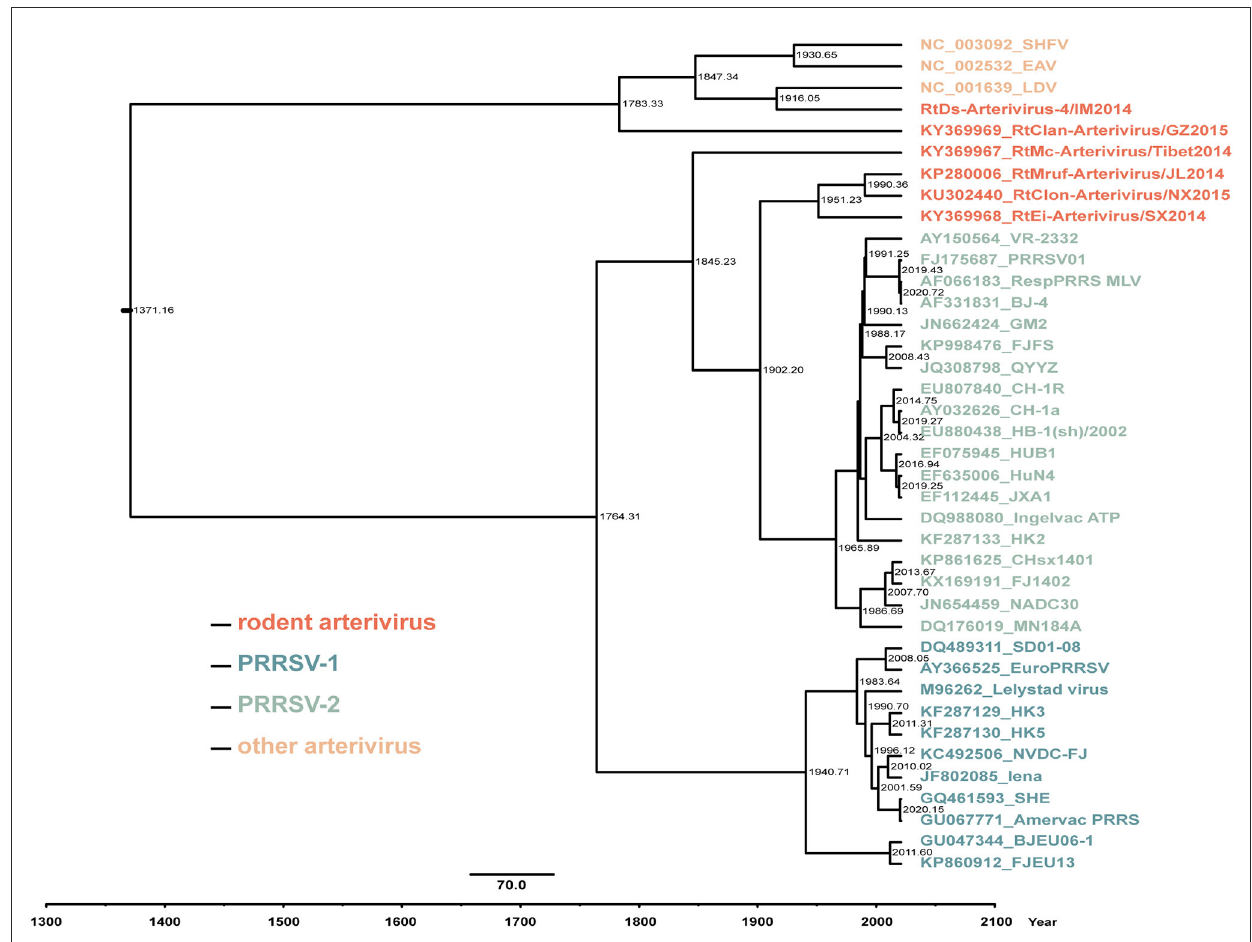
FIGURE6 Estimation of the mean time to the most recent common ancestor (tMRCA) for arterivirus based on the helicase (Hel) gene. The time-scaled phylogeny was summarized from all Markov chain Monte Carlo (MCMC) phylogenies of the Hel gene data set analyzed under the GTR + F + G4 nucleotide substitution model and the uncorrelated lognormal relaxed constant clock model in BEAST v1.10.4. The numbers near the internal node indicate the estimated time of